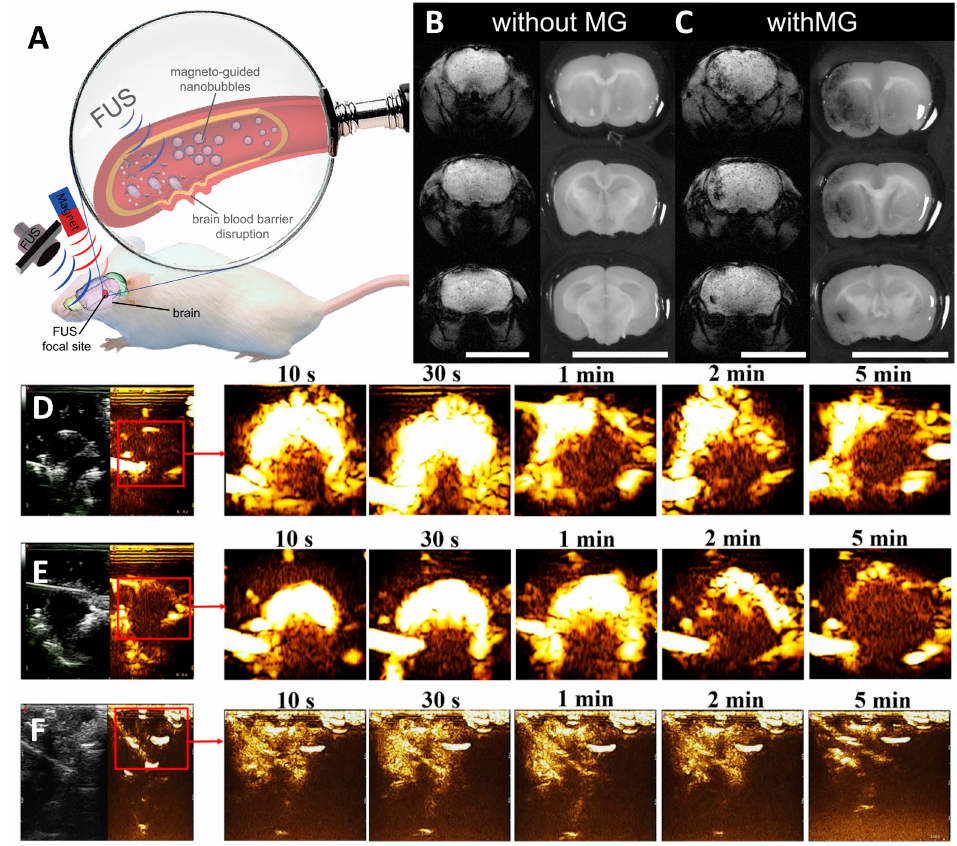
Figure 3. ( A ) Nanobubbles can be used to diagnose locally disrupted BBB and accumulate due to magnetic guidance (MG). ( B ) Representative images of T2 gradient brain slices and their corre- sponding dye-treated brain tissue slices, used to assess the efficiency of bubble-free and magneti- cally guided brain tissue BBB disruption. ( C ) Biosafety induced by focused ultrasound compared to different degrees of BBB destruction caused by nanobubbles. Contrast-enhanced ultrasound imag- ing of brain tumors at other timepoints (10 s to 5 min) before and after injection of ( D ) nanobubbles and ( E ) commercial SonoVue. ( F ) Brain cavity ultrasound images at the same timepoint before and after the injection of NBs. Red squares show image enhancement of specific tissue sites.